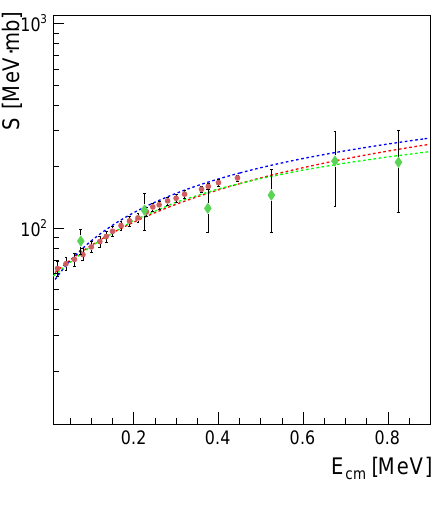
Figure 2: Bare nucleus TH S(E) for p - 3 H channel obtained by the 6 Li break-up [ 9 ] (as green diamonds) and by the 3 He break-up [ 11 ] (as red dots). The red and blue lines are the polynomial fit by [ 17 ] and [ 16 ] , while the green line is the ab initio calculation by [ 21 ]